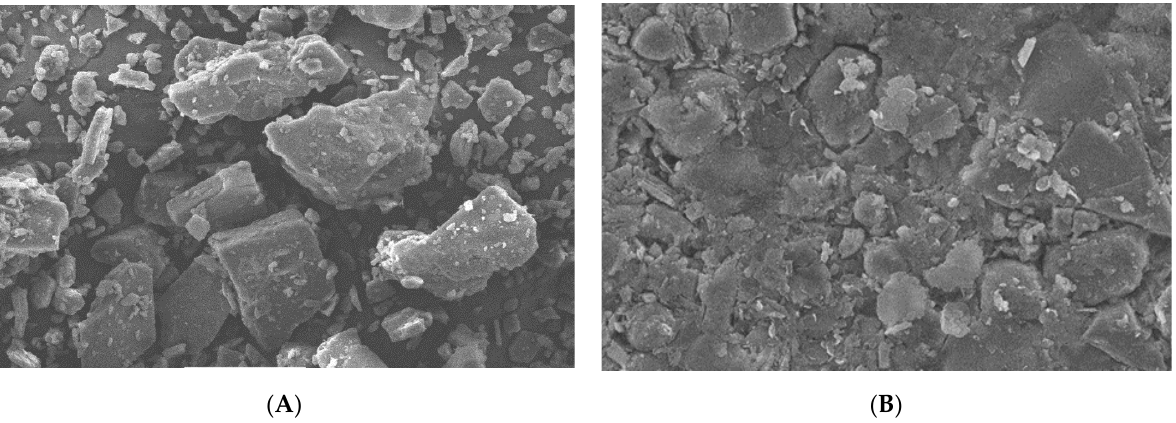
Figure 8. Scanning electron photomicrograph for pure drug ( A ) and for liquisolid compact ( B ).